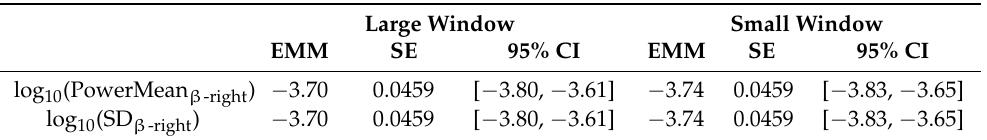
Regarding the sky type, log 10 of Mean θ on both the left (F(1, 88.074) = 8.2583, p = 0.00208) and right (F(1, 4.7805) = 11.0845, p = 0.00123) prefrontal lobe areas are influenced by the sky types. Table 9 lists the estimated marginal means (EMM), SE and 95% confidence intervals (CI) of the sky types for log 10 of Mean θ -left (B = − 3.56 × 10 − 6 , p = 0.0045) and log 10 of Mean θ -right (B = − 4.27 × 10 − 6 , p = 0.0010). The mean theta values on both the left and right prefrontal lobe areas under the overcast sky were three times greater than the mean theta values under the clear sky. In other words, the clear sky attenuates the theta rhythm on the prefrontal lobe